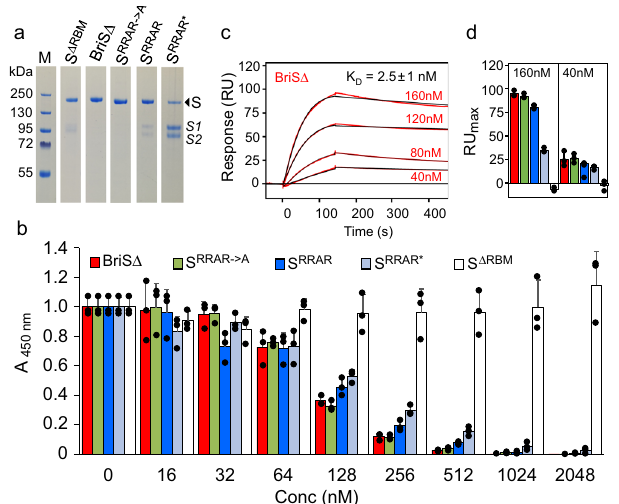
Fig. 3 Functional analysis of SARS-CoV-2 S proteins. a Coomassie-stained SDS-PAGE sections of S protein variants used for biochemical characterization. Protein puri fi cations were carried out at least three times each. b Competition ELISAs utilizing immobilized ACE2, HRP-labeled RBD, and S proteins (shown in different colors) at the concentrations indicated. Error bars: standard deviations ( + SD) are shown, three replicates. c Surface plasmon resonance (SPR) of BriS Δ . Concentrations between 40 nM and 160 nM were fl owed over 50 RU of biotinylated ACE2 immobilized on a streptavidin-coated sensor chip. Black lines correspond to a global fi t of the data using a 1:1 binding model. Each experiment was repeated independently three times. All protein concentrations were used to calculate the K D value. Source data are provided as a Source Data fi le. d SPR analysis comparing maximal binding (RUmax) of the S protein variants at two representative concentrations (160 nM, 40 nM). Color coding as in panel b